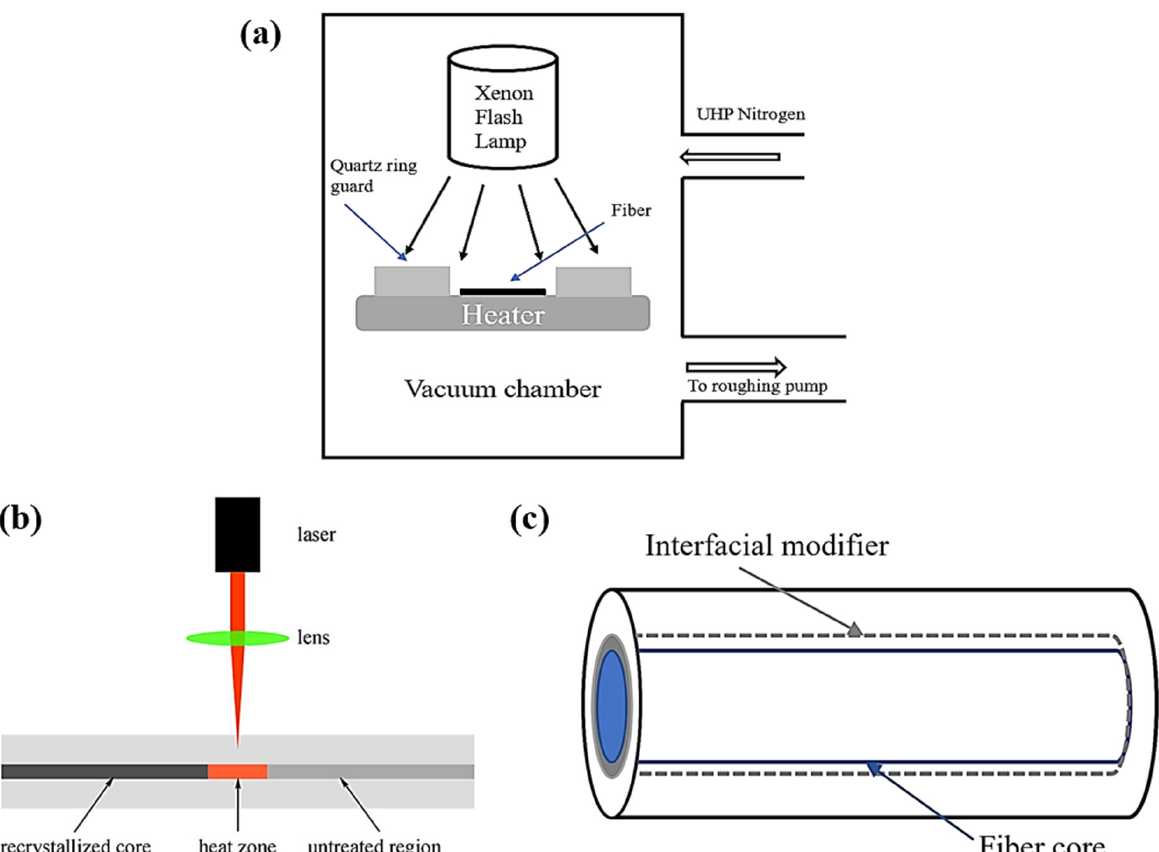
Figure 4. Postprocessing techniques: ( a ) RPP, ( b ) Laser treatment (Reprinted with permission from ref. [93]. Copyright 2021 Hei Chit Leo Tsui et al.), and ( c ) Interfacial modifier.